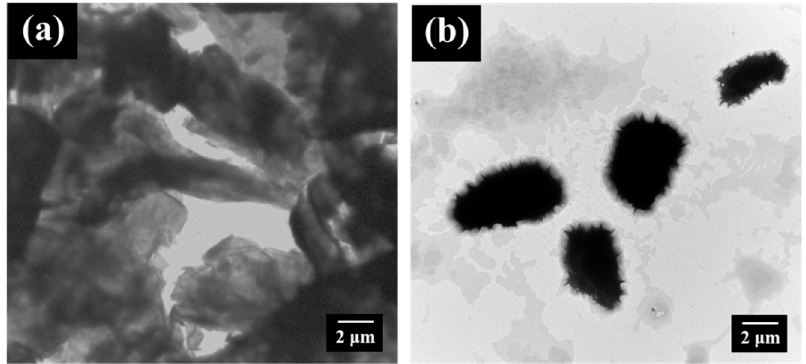
Figure 5. TEM images of ( a ) pristine graphene and ( b ) PEBF / graphene samples.